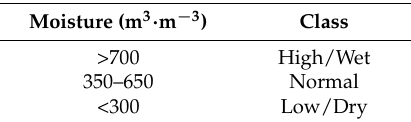
Table 4. Moisture levels.